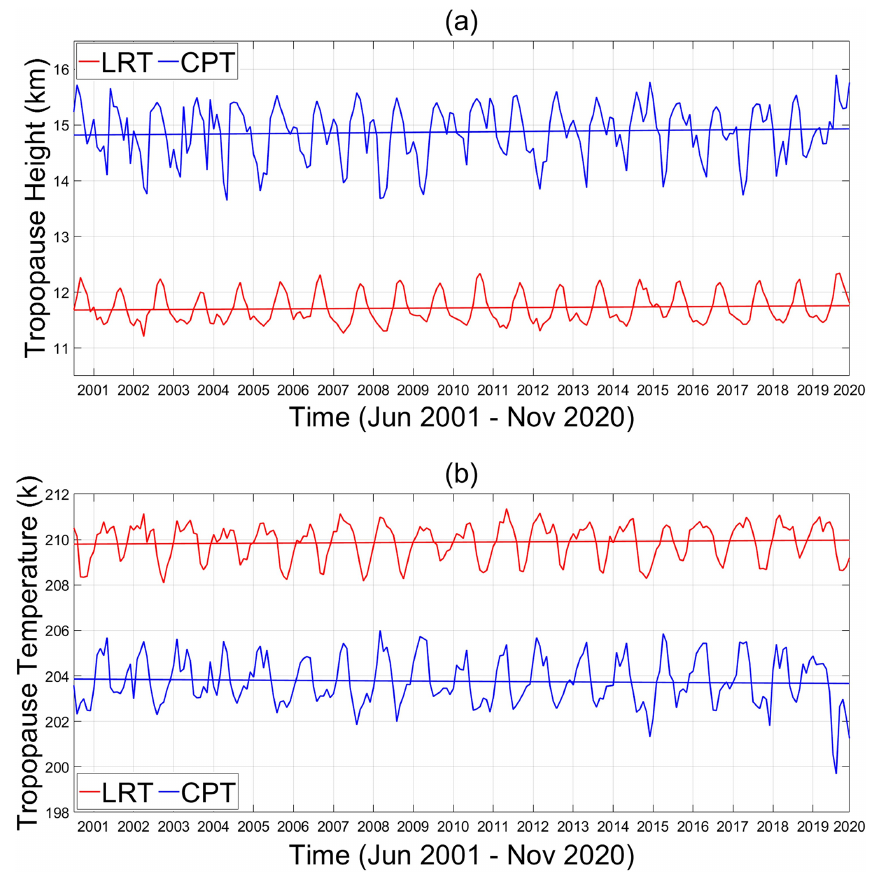
Figure 3. The LRT and CPT (a) height and (b) temperature are shown from 2001 to